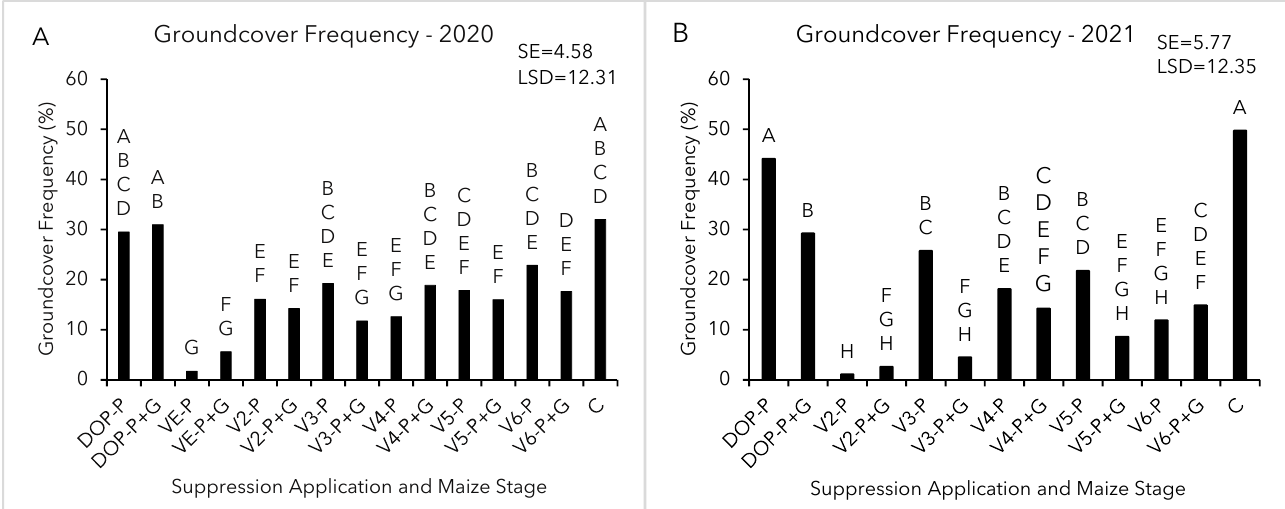
Figure 2. ( A ) End-of-season groundcover frequency for treatments at the Sorenson Research Farm in 2020 and ( B ) end-of-season groundcover frequency for treatments at the Sorenson Research Farm in 2021. The standard error (SE) and least significant difference (LSD) are presented for each year, and uppercase letters above the treatment denote the LSD ranking for that treatment. Abbreviations are as follows: P, paraquat; P + G, paraquat + glufosinate; DOP, day of maize planting; VE, VE maize stage; V2, V2 maize stage; V3, V3 maize stage; V4, V4 maize stage; V5, V5 maize stage; V6, V6 maize stage; C, Control.